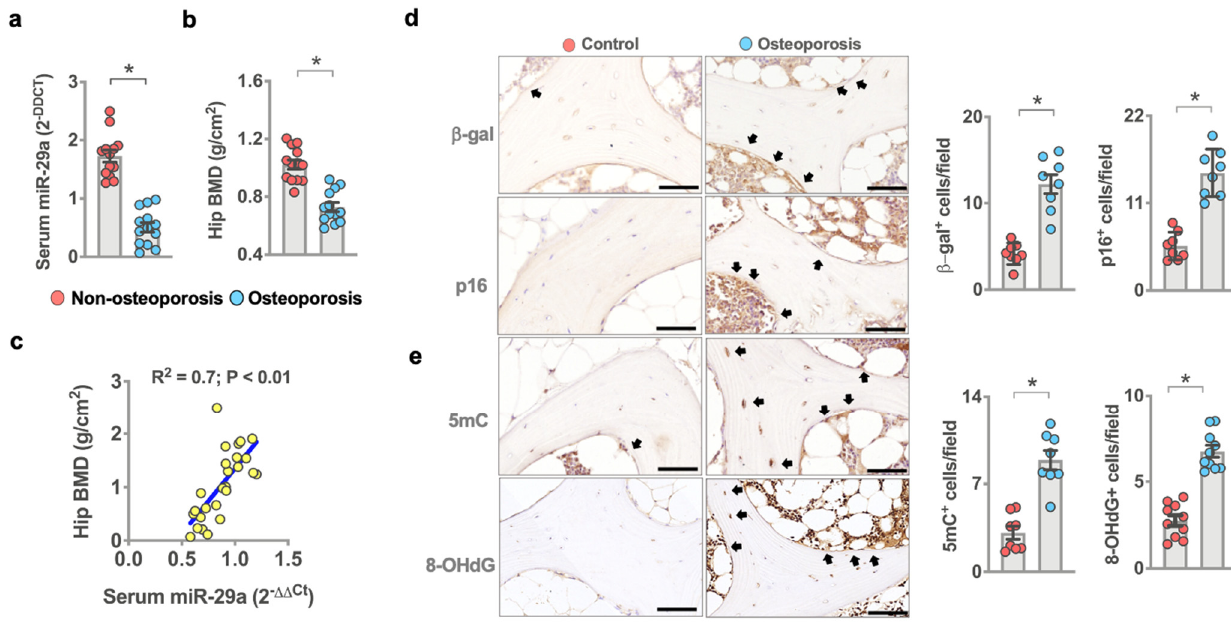
Figure 1. Analysis of miR-29a , osteoblast senescence, oxidative stress, and DNA methylation in human osteoporosis. Decreased serum miR-29a levels ( a ) and hip BMD ( b ) in the osteoporosis group. Serum miR-29a levels correlated with osteoporosis ( c ). Data are mean ± standard error calculated from 13 patients without osteoporosis and 13 patients with osteoporosis who required spine surgery. Osteoblasts in age-mediated osteoporotic bone showed strong β -galactosidase, p16 ( d ), 5mC, and 8-OHdG ( e ) immunostaining (arrows) (scale bar, 20 µ m). Immunohistochemical data (mean ± standard error) are calculated from 7–8 bone biopsies. Significant difference (asterisks *) was analyzed using a Wilcoxon test.